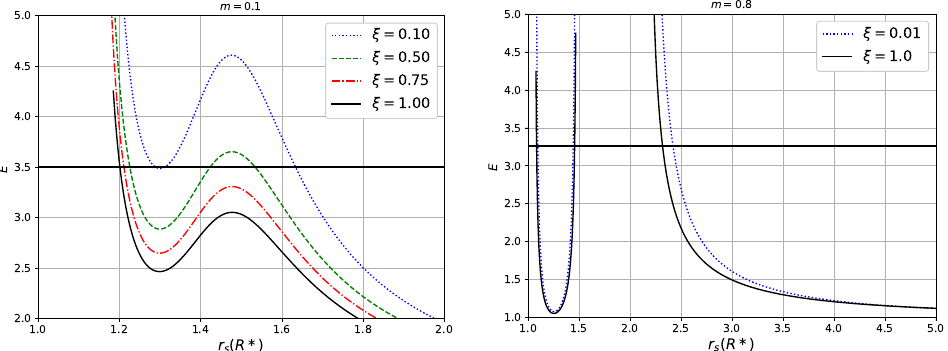
Figure 7. E − r s parameter space for various choices of jet composition. Left panel : ξ = 0.1 (dotted blue) 0.5 (dashed green), 0.75 (dashed–dotted red) and 1.0 (solid black) for a moderate cocoon strength with m = 0.1. Velocity profiles corresponding to E = 3.5 (horizontal black solid line) are plotted in Figure 8. Right panel : ξ = 0.01 (dotted blue) and 1.0 (solid black). Solutions of E = 3.26 (horizontal black solid line) are shown in Figure 9.